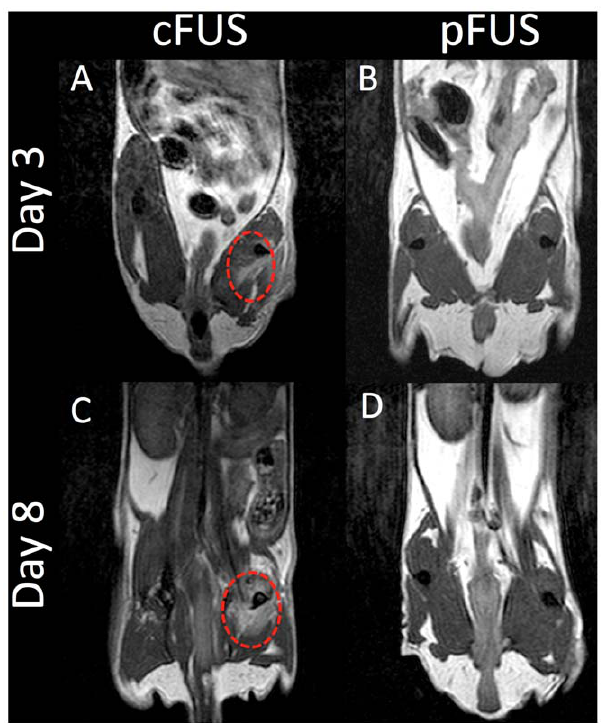
Figure 3. Evaluation of FUS-treated muscle tissue by T 2 - weighted MRI. T 2 -weighted MR images were obtained at 3T after 3 ( A and B ) and 8 ( C and D ) days post-FUS. Imaging reveals persistent edema on days 3 and 8 in regions of the right leg that were treated with cFUS exposures ( A and C ) but not pFUS exposures ( B and D ).